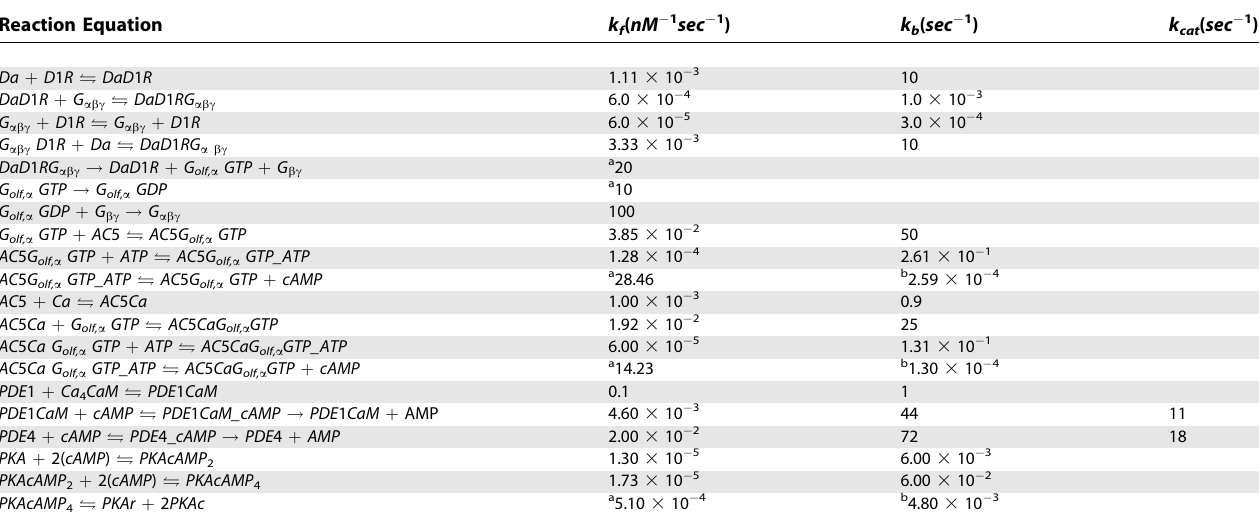
Table 1. Reactions and Rate Constants of Dopamine–PKA Pathway Reaction Equation